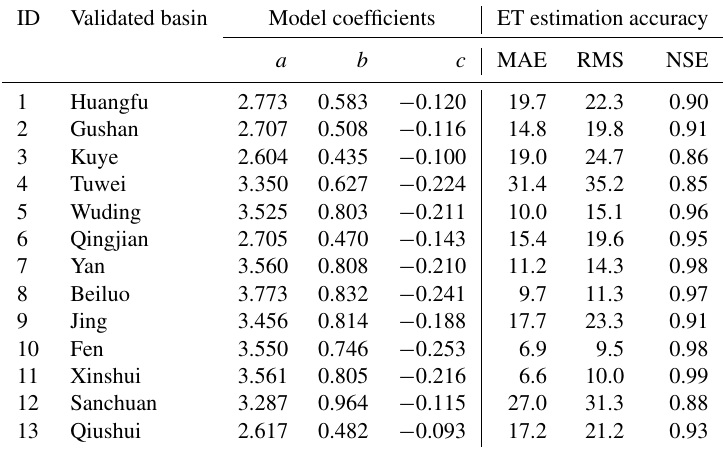
Table 2. Cross-validation results for each basin.